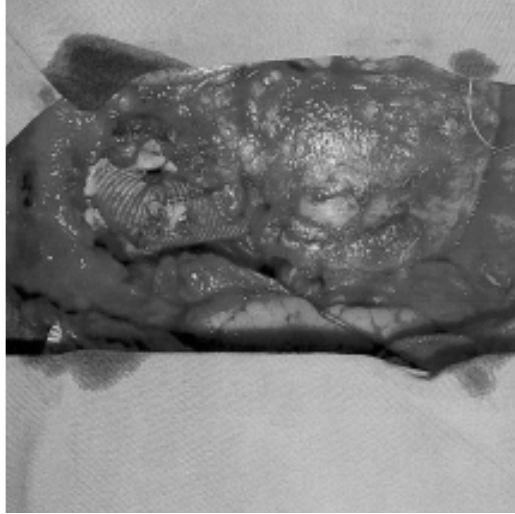
Fig. 3 - Final aspect of the surgery. Anastomosis between the two Dacron tubes and anastomosis between the saphenous vein bypass grafts and the tube.